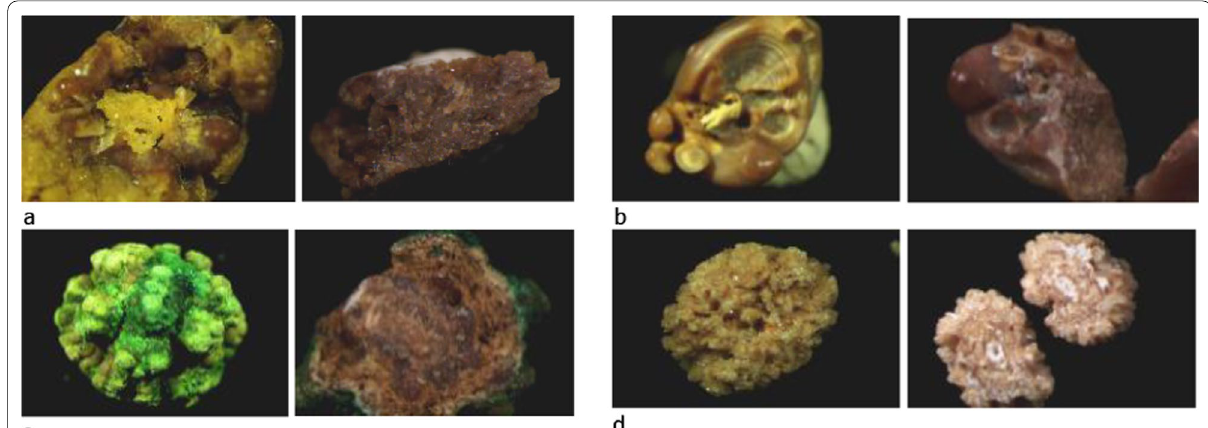
Fig. 1 Illustration of some stones analyzed a stone surgically extracted from the right ureter of 12 mm in diameter, irregular shape with Randall’s plate, morphology IIb Ia b stone of the right ureter of 5.5 mm in diameter, irregular shape, morphology Ia with Randall’s plate c stone extracted + from the bladder of 10 mm in diameter of irregular shape and hilly surface, bluish to dark brown (Ia Ib VIb and depth Ia. Non‑individualized nucleus (Ia). d calculus spontaneously eliminated from the left ureter of a patient 6 mm in diameter, oval + with a crystalline surface, spiculated light brown‑yellow